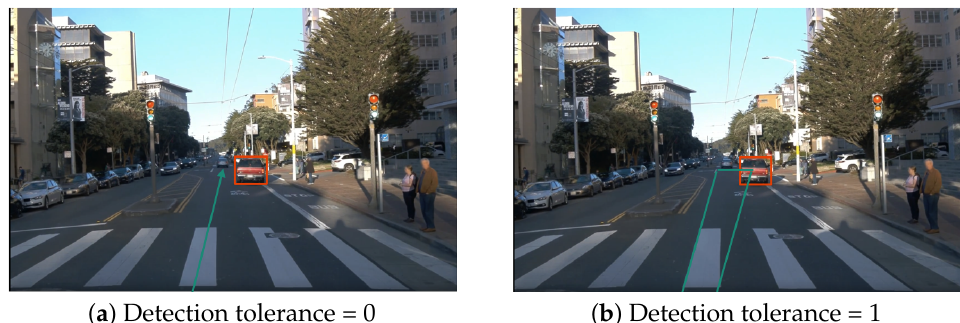
Figure 1. Examples of two different detection tolerances applied to the same scenario, displayed on visualizations of camera images in the Waymo Open Dataset.